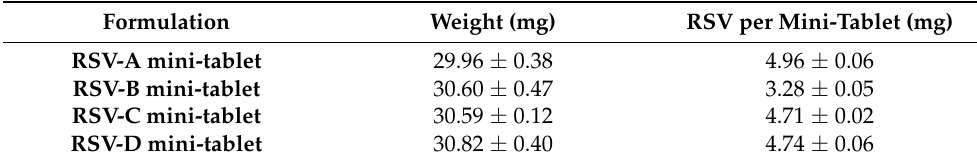
Table 5. RSV-loaded sublingual mini-tablets: weight and drug content ± SE ( n = 6). Formulation Weight